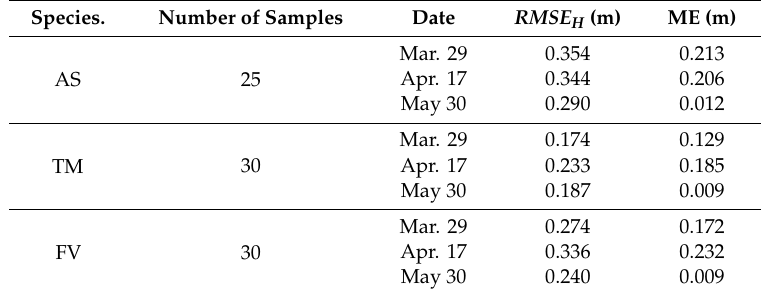
Table 4. Digital elevation model (DEM) accuracy evaluation at three tree study sites on three dates. The RMSE H is the total error in the ground elevation; ME is the mean